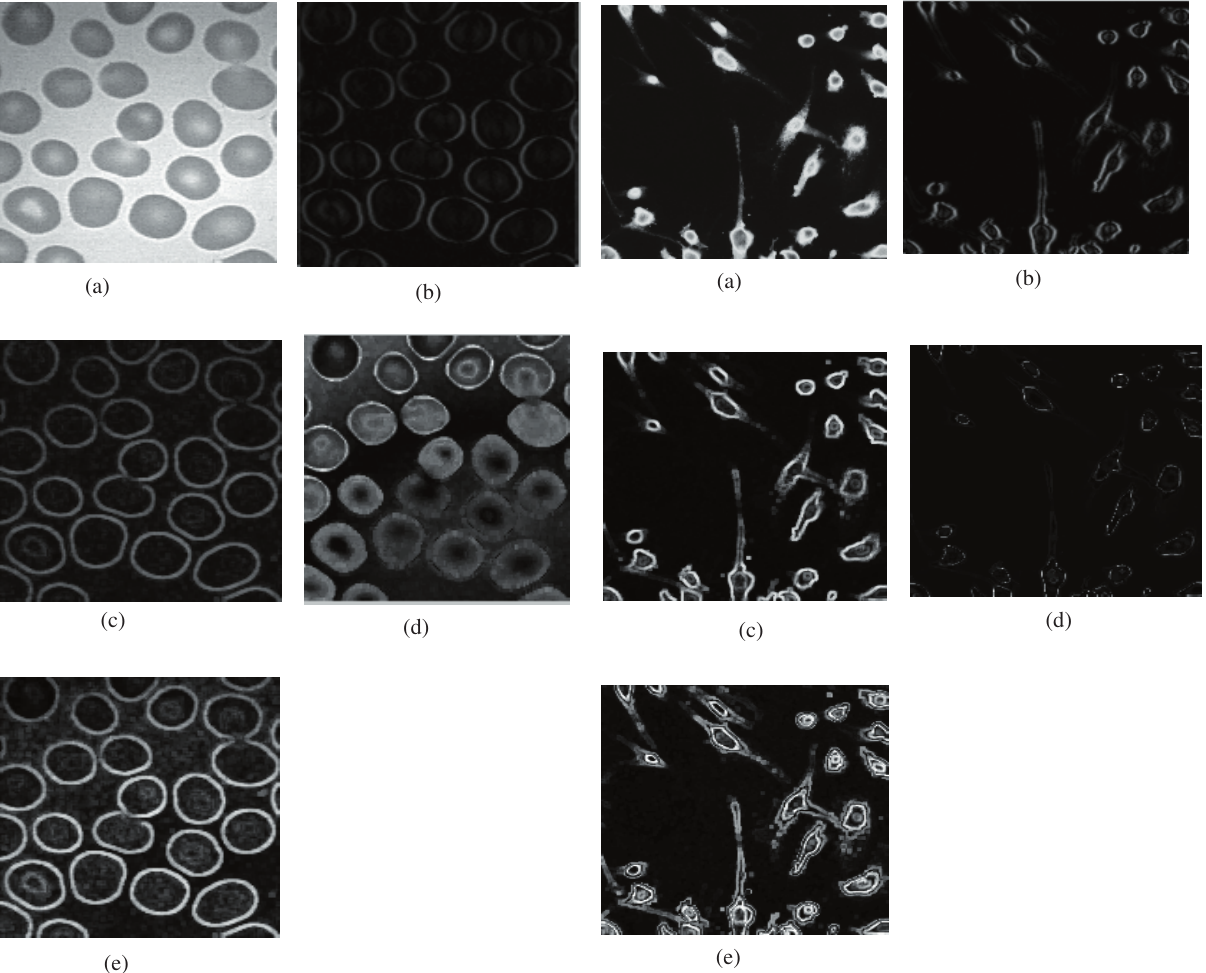
Fig. 5. : a) cell image, b) edge image using fuzzy morphology, c) edge image using the interval valued fuzzy set, d) edge image by Chaira and Ray , e) edge image using proposed method